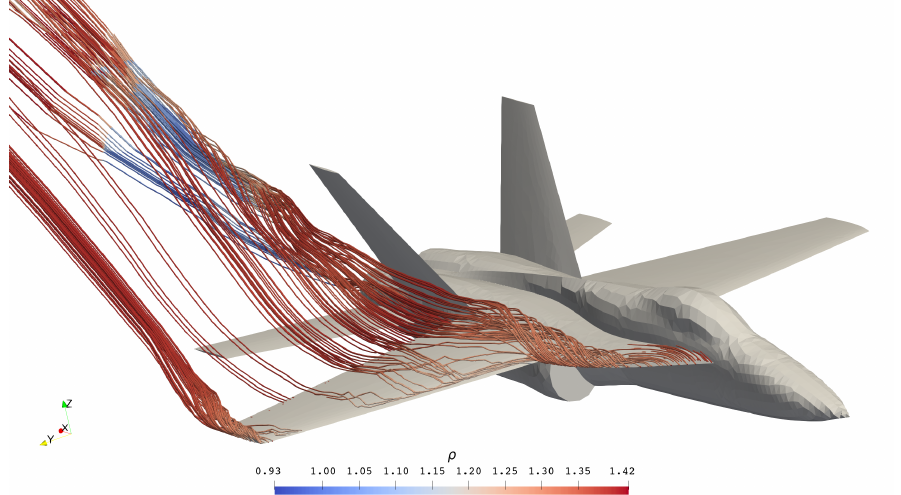
Figure 21. Streamlines given by the first-order solution of Problem 5.